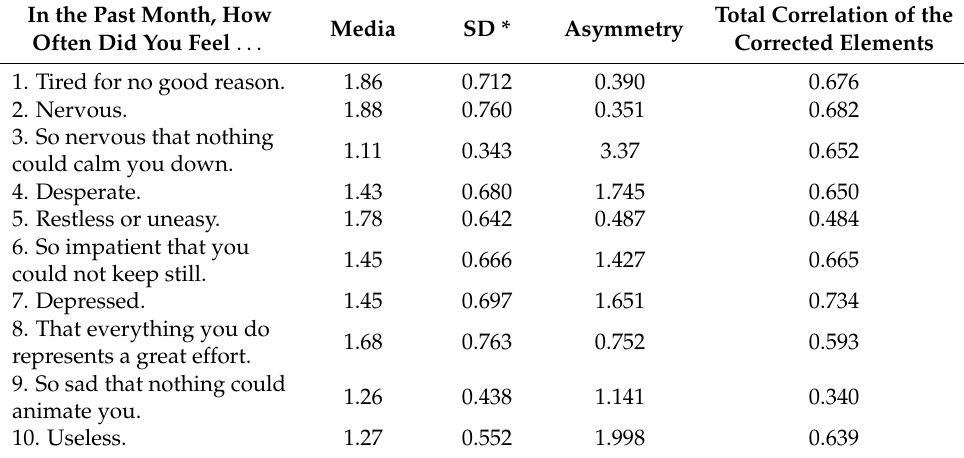
Table 2. Descriptive analyses and reliability of the Psychological Distress in Non-Formal Con- texts scale.